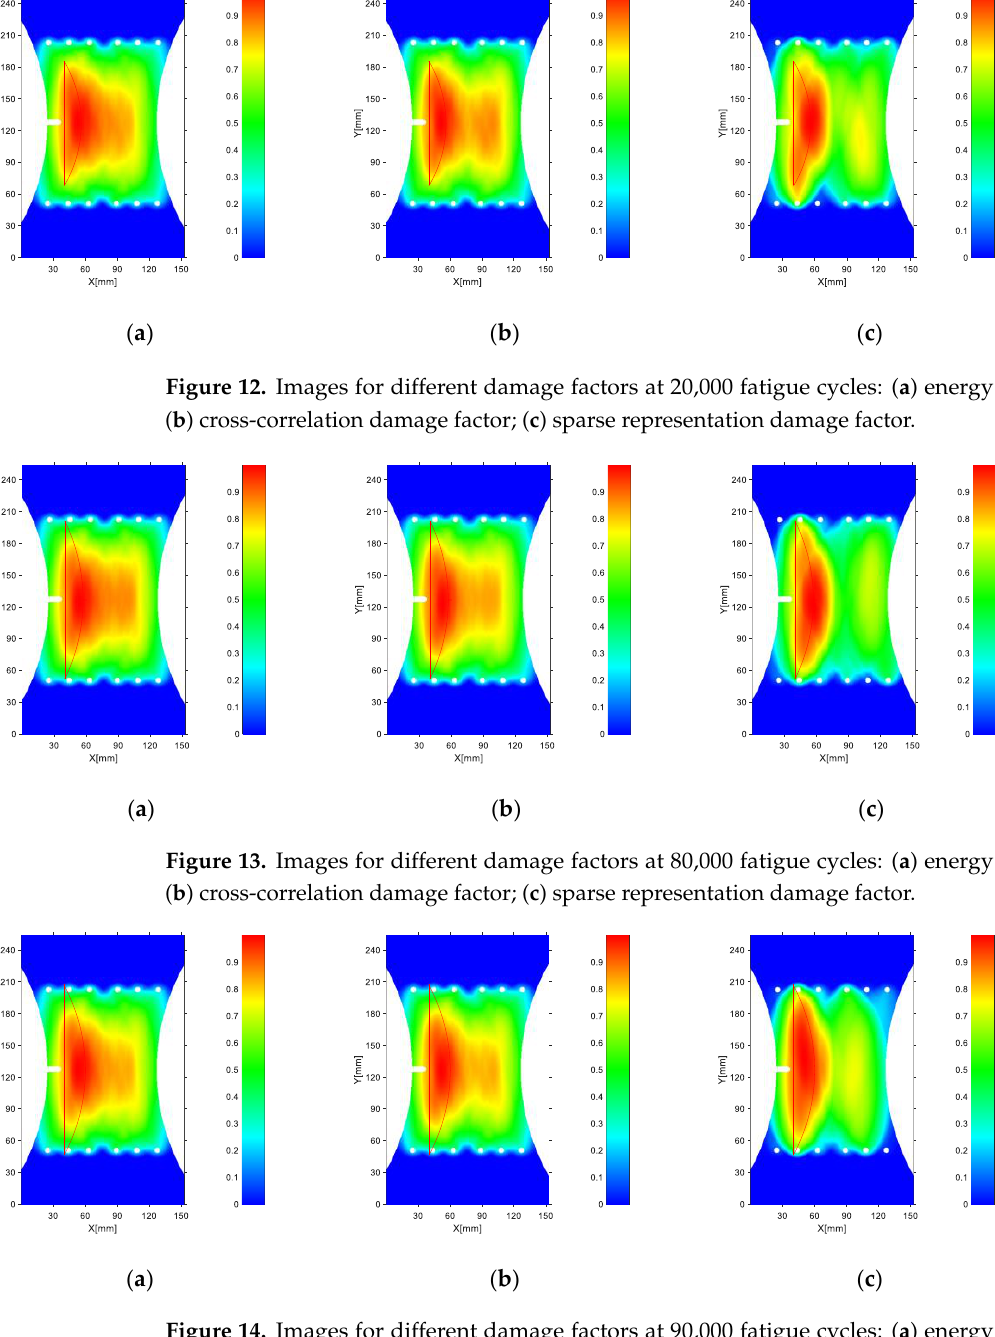
( c ) Figure 15. Thresholded imags for different damage factors at 20,000 fatigue cycles: ( a ) energy dam- age factor; ( b ) cross-correlation damage factor; ( c ) sparse representation damage factor.